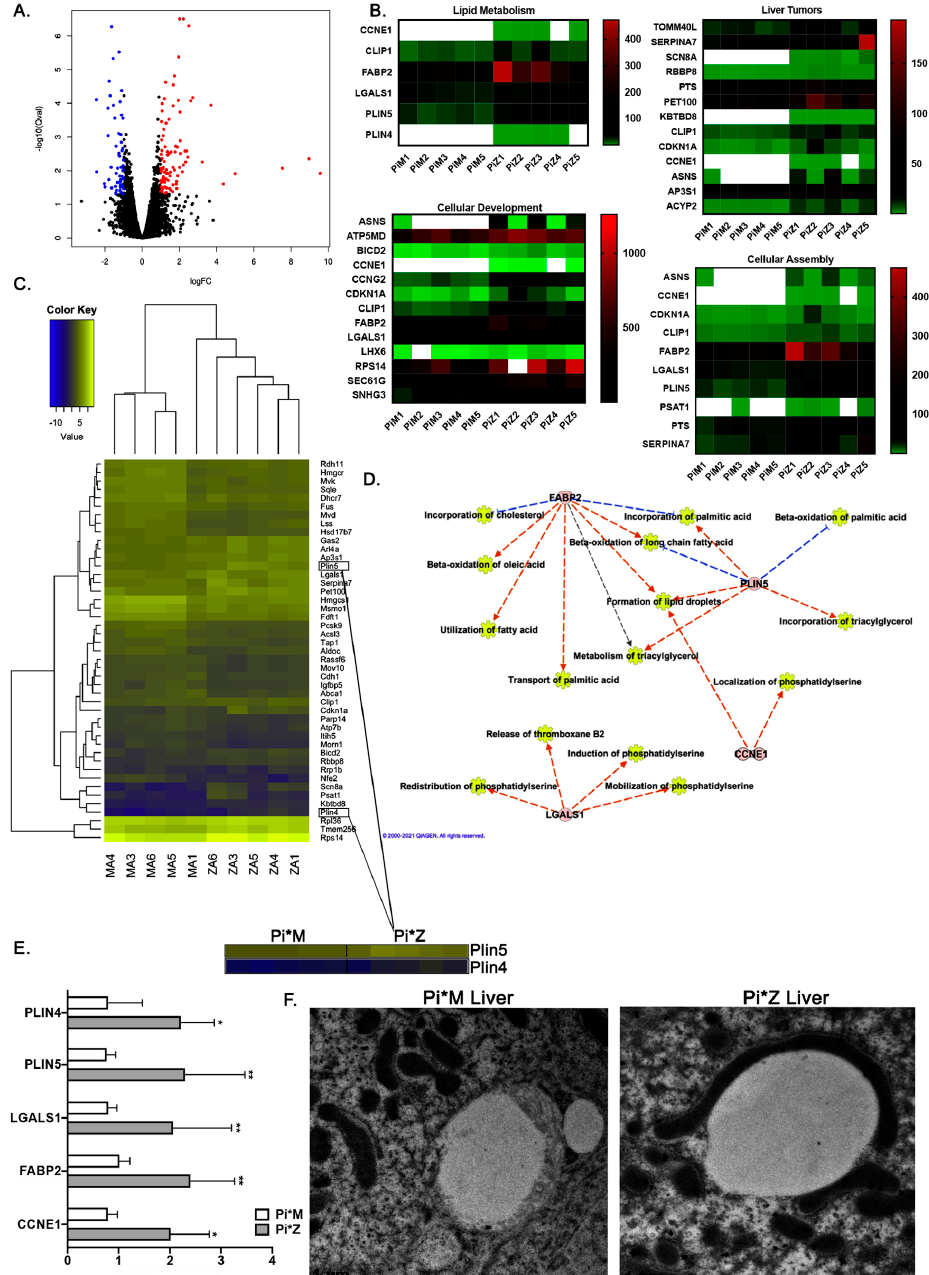
Figure 2. Dysregulation of lipid metabolism pathways and mitochondrial abnormalities in Pi*Z transgenic mice. ( A ) Volcano plot of log2 fold change (logFC) vs. p -value between Pi*Z and Pi*M liver tissues. Black circles represent RNAs with a p > 0.05, blue circles represent downregulated RNAs with a p < 0.05 and a fold change greater than 2, and red circles represent upregulated RNAs with a p < 0.05 and a fold change greater than 2. ( B ) The related heatmap of the enriched pathways identified by IPA (ingenuity pathway analysis) from differentially expressed RNAs between Pi*M and Pi*Z mice liver tissues. ( C ) The related heatmap of the differentially expressed RNAs between Pi*M and Pi*Z mice liver tissues involved in lipid metabolism pathway. ( D ) Functional repertoire of 4 upregulated RNAs in Pi*Z transgenic mice liver tissues involved in the elevation of lipid metabolism pathway using IPA software. Blue lines indicate direct inhibition and orange lines indicate direct activation. ( E ) Relative expression of Ccne1, Fabp2, Lgals1, Plin5, and Plin4 genes using qRT-PCR data derived from Pi*M and Pi*Z transgenic mice liver tissues. ( F ) Immuno-electron microscopy results determining the morphology and localization of the mitochondria in the liver tissue from Pi*M and Pi*Z transgenic mice. * p < 0.05, ** p <